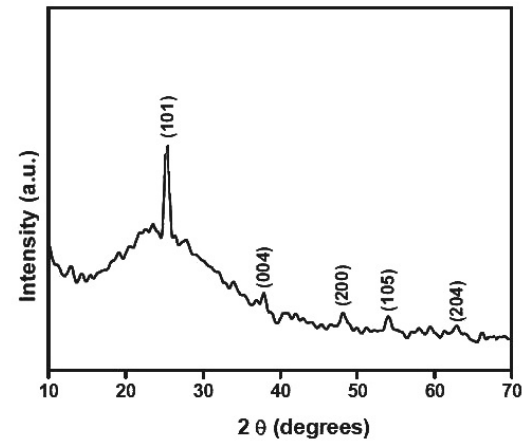
Fig.1. The XRD pattern of the TiO